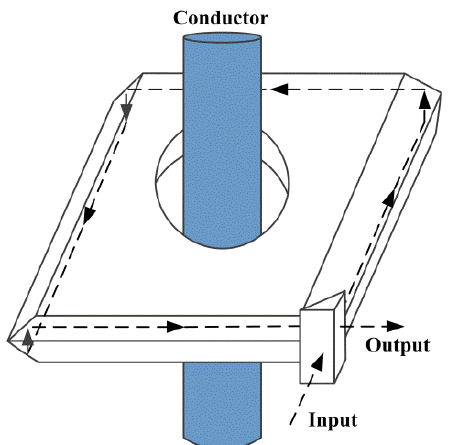
Figure 9. Bulk optic current sensor with double reflection.